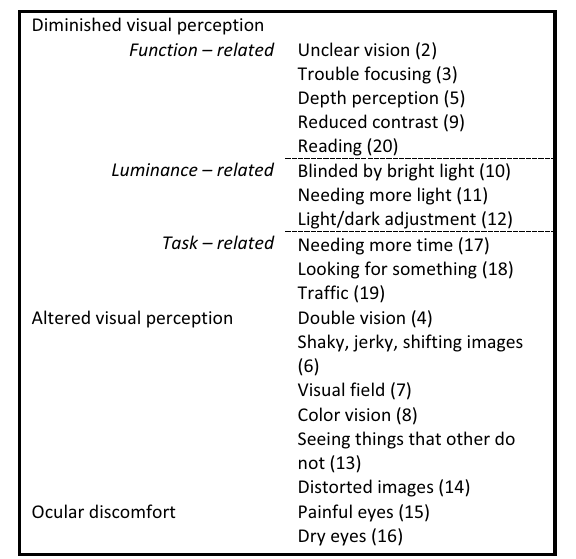
Fig. 1 Scales of the SVCq [7] and its items. *The numbers in brackets represent the item number in the